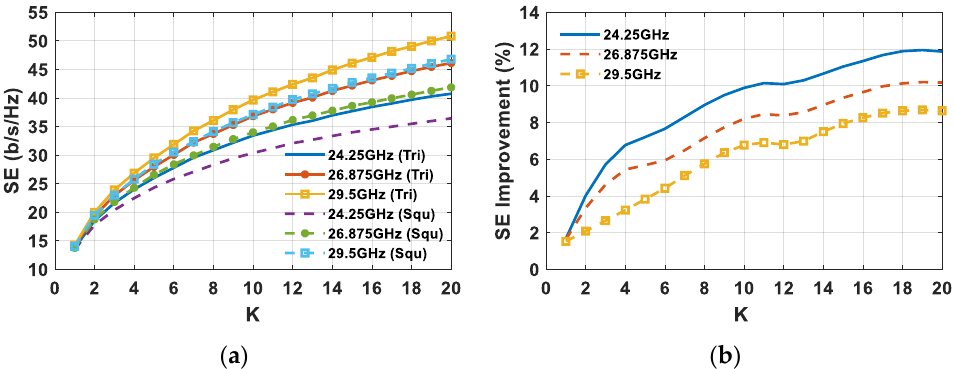
Figure 18. ( a ) SE comparison as a function of the number of users ( K ) between square and triangular lattice planar arrays composed of 64 elements; and ( b ) percentage SE improvement in the event of δ = 20 dB.